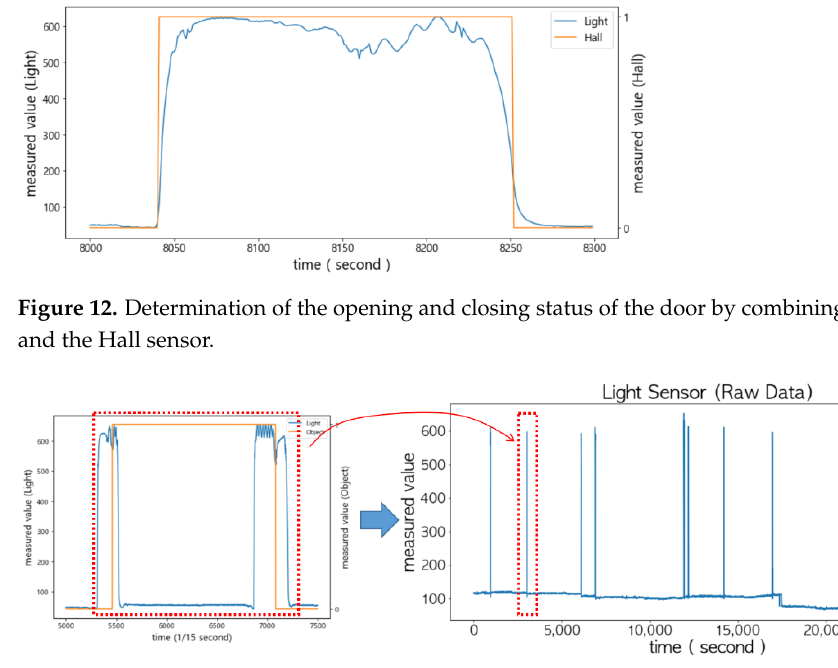
Figure 13. The sensed values of the light sensor: sampling 15 times per second ( left ) and sampling once per second ( right ).